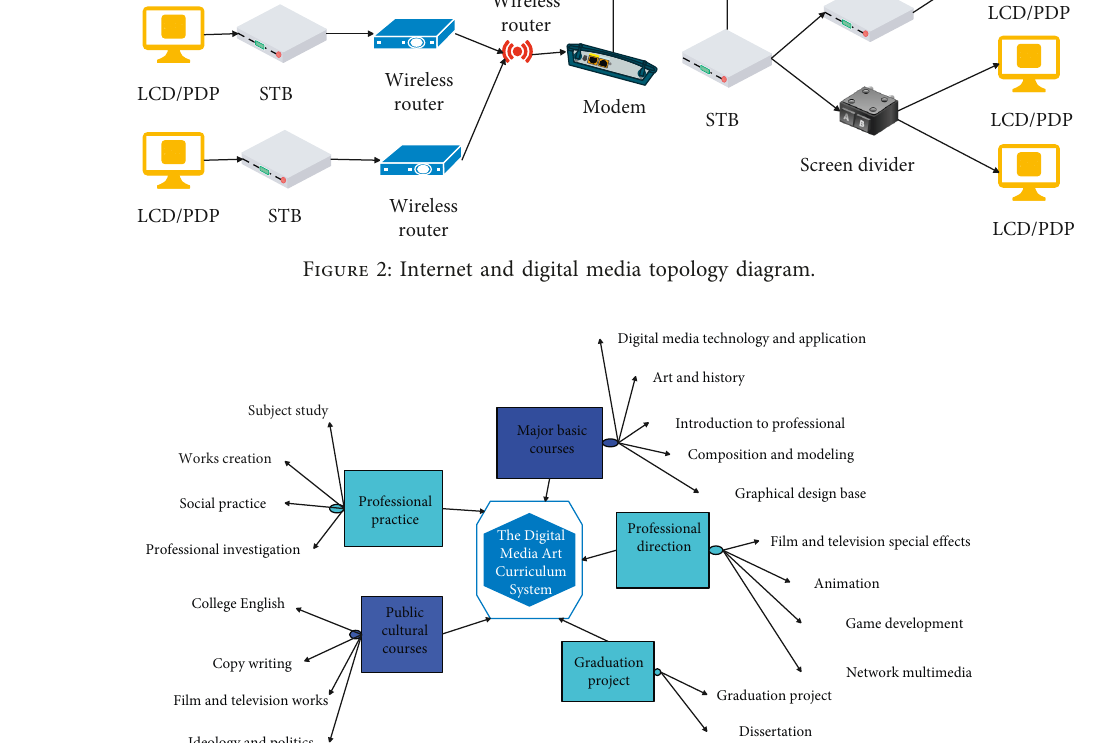
Figure 3: Diagram of digital media art course